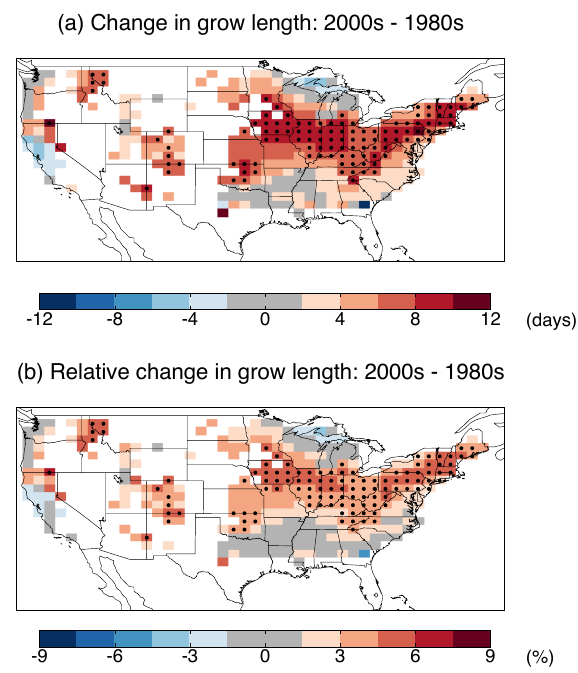
Figure 6. The (a) difference and (b) its relative change in the growth length for US deciduous forests between 2000s and 1980s. Signifi- cant changes ( p <0.05) are denoted with dots.